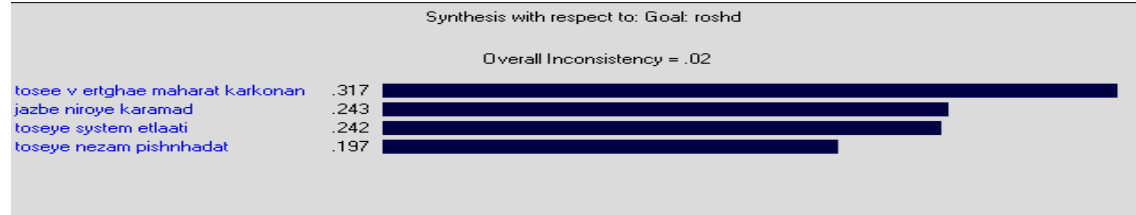
Figure 5. Results of the final combination of learning and growth perspective